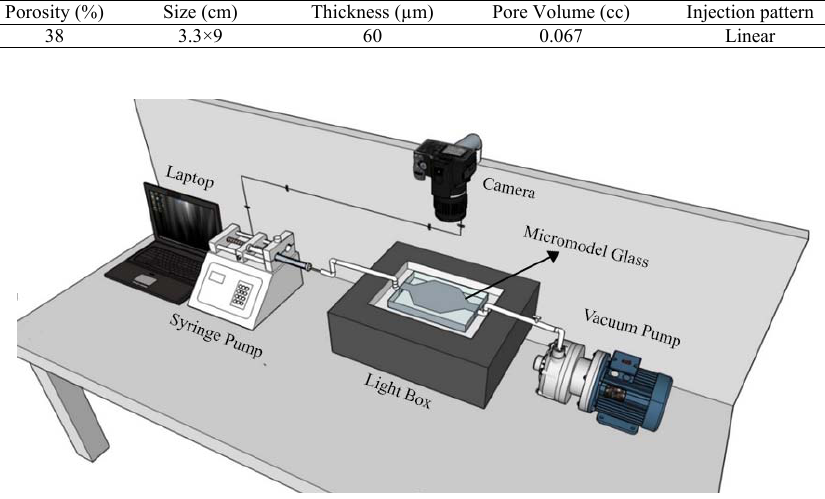
Fig. 2. Schematic of the micromodel